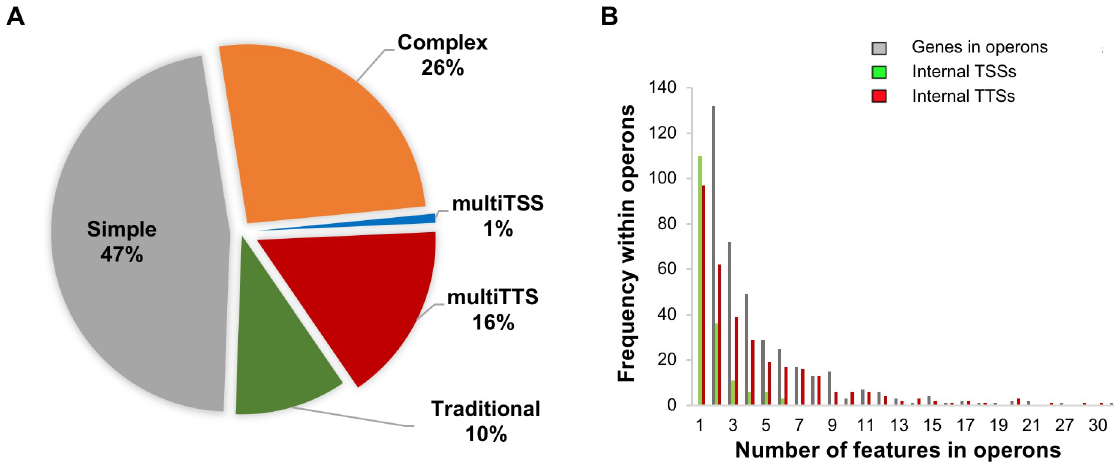
Fig 3. Distribution of operon types in the genome and frequency of transcriptional features within non-traditional operons identified using StringTie. (A) The pie chart describes the distribution of the types of operons present in T4 annotated using only high confidence TSSs. A total of 388 multigene and 343 single gene operons were identified, which can be divided up in 47% simple operons (single gene transcriptional units with a single TSS and TTS; gray), 26% complex operons (multi-gene operons with multiple TSSs and TTSs; orange), 10% traditional operons (multi-gene operon with a single TSS and TTS; green), 1% multiTSS operons (blue), and 16% multiTTS operons (red). ( B) The clustered histogram describes the distribution of genes and transcriptional features in non-traditional operons, where gray represents the numbers of genes in the multigene operons, green represents the number of TSSs within operons, red represents the number of TTSs within operons. Two-gene operons are found most frequently in the non-traditional operons with one internal TSS and TTS.